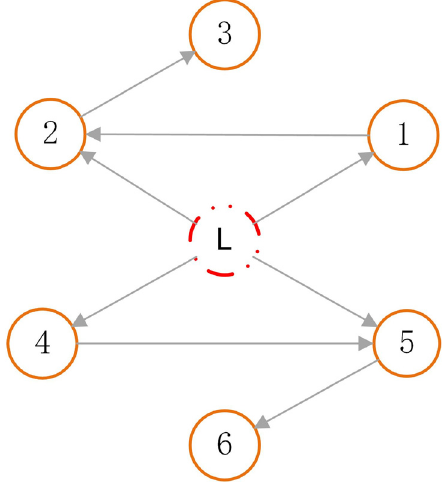
Figure 3: Communication topology of the agent system.